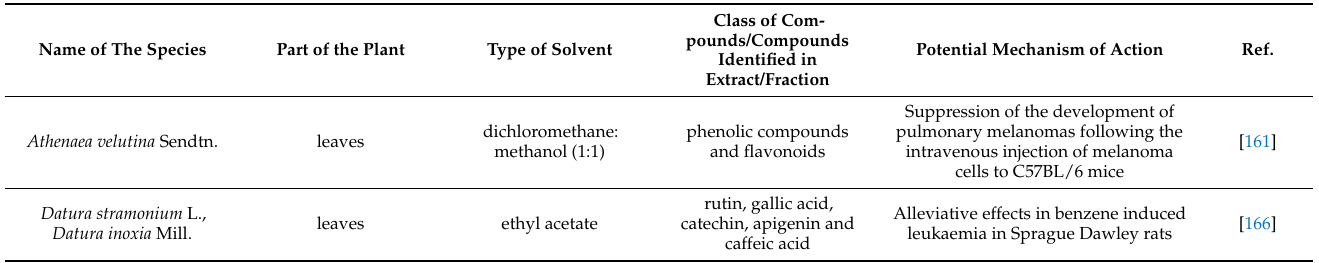
Table 5. In vivo anticancer effect of plant extracts and pure compounds from the Solanaceae family and their potential mechanisms of